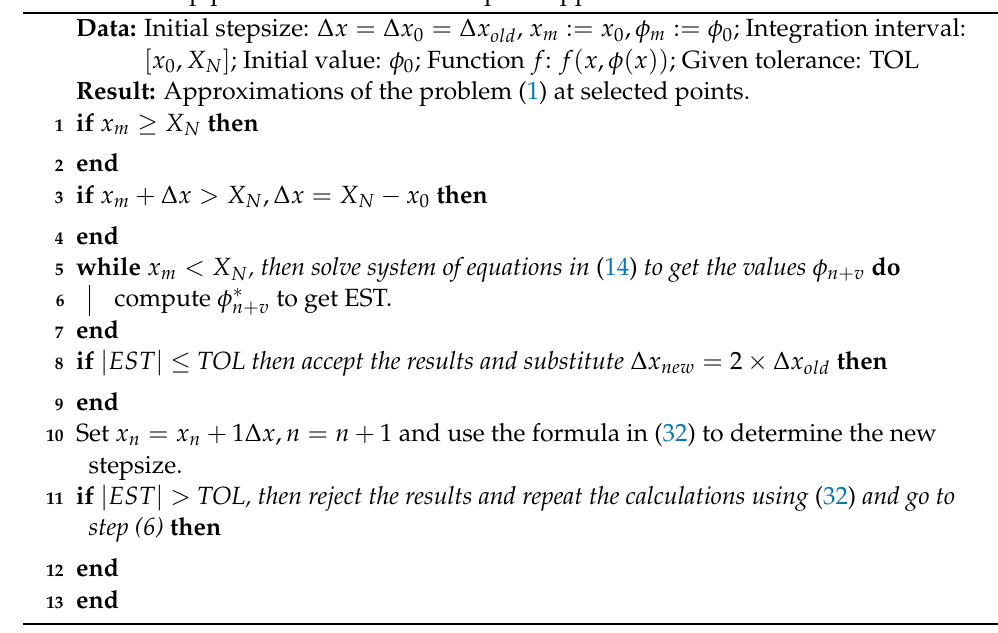
Algorithm 2: Pseudo-code for the two-step optimized hybrid block method with two intra-step points under variable stepsize